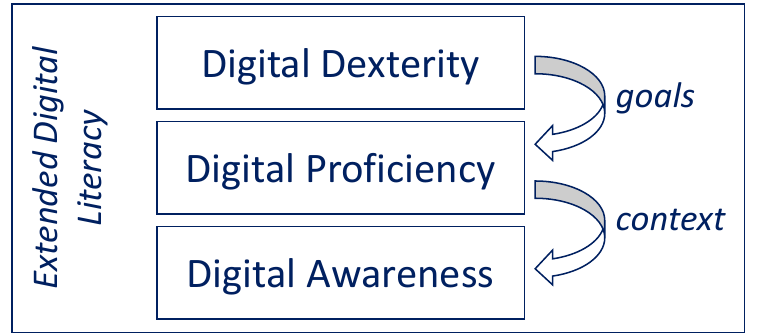
Figure 1. Components of extended digital literacy.